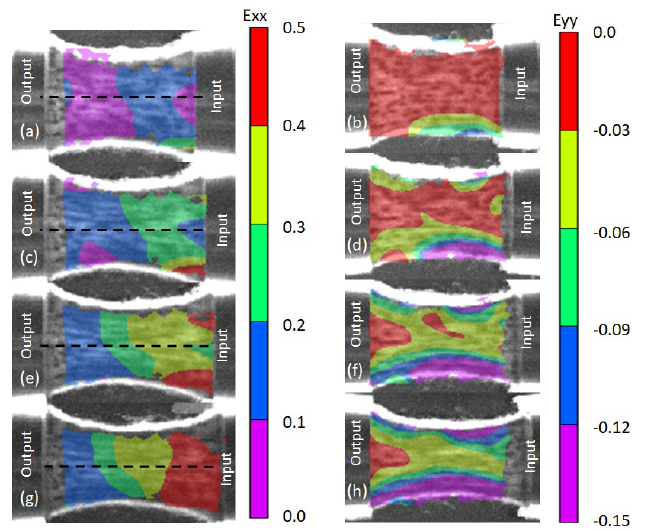
Figure 9. Evolution of the longitudinal strain ε x ( a , c , e , g ) and lateral strain ε y ( b , d , f , h ). ( a , b ) t = 0.2 ms, ( c , d ) t = 0.4 ms, ( e , f ) t = 0.6 ms, ( g , h ) t = 0.9 ms. Dashed line represents the mid-line used to monitor longitudinal strains and strain rates in Figure 10.